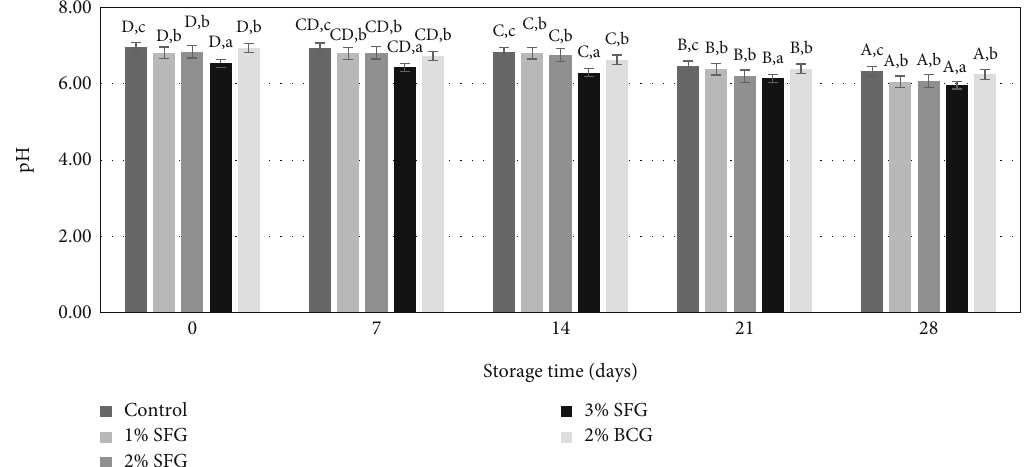
Figure 3: E ff ect of addition of gelatin to pH of sausage during storage. Di ff erent uppercase letters indicate di ff erences in storage time ( p < 0 : 05 ), and lowercase letters indicate di ff erences with level gelatin ( p < 0 : 05